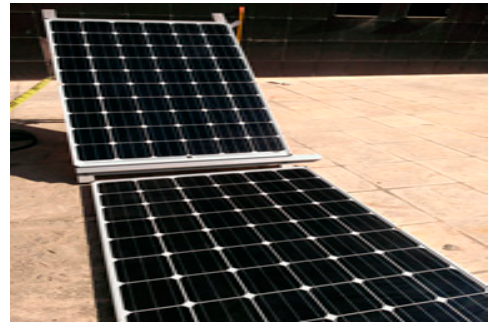
Figure 1. Installed panels for the experiment at study.